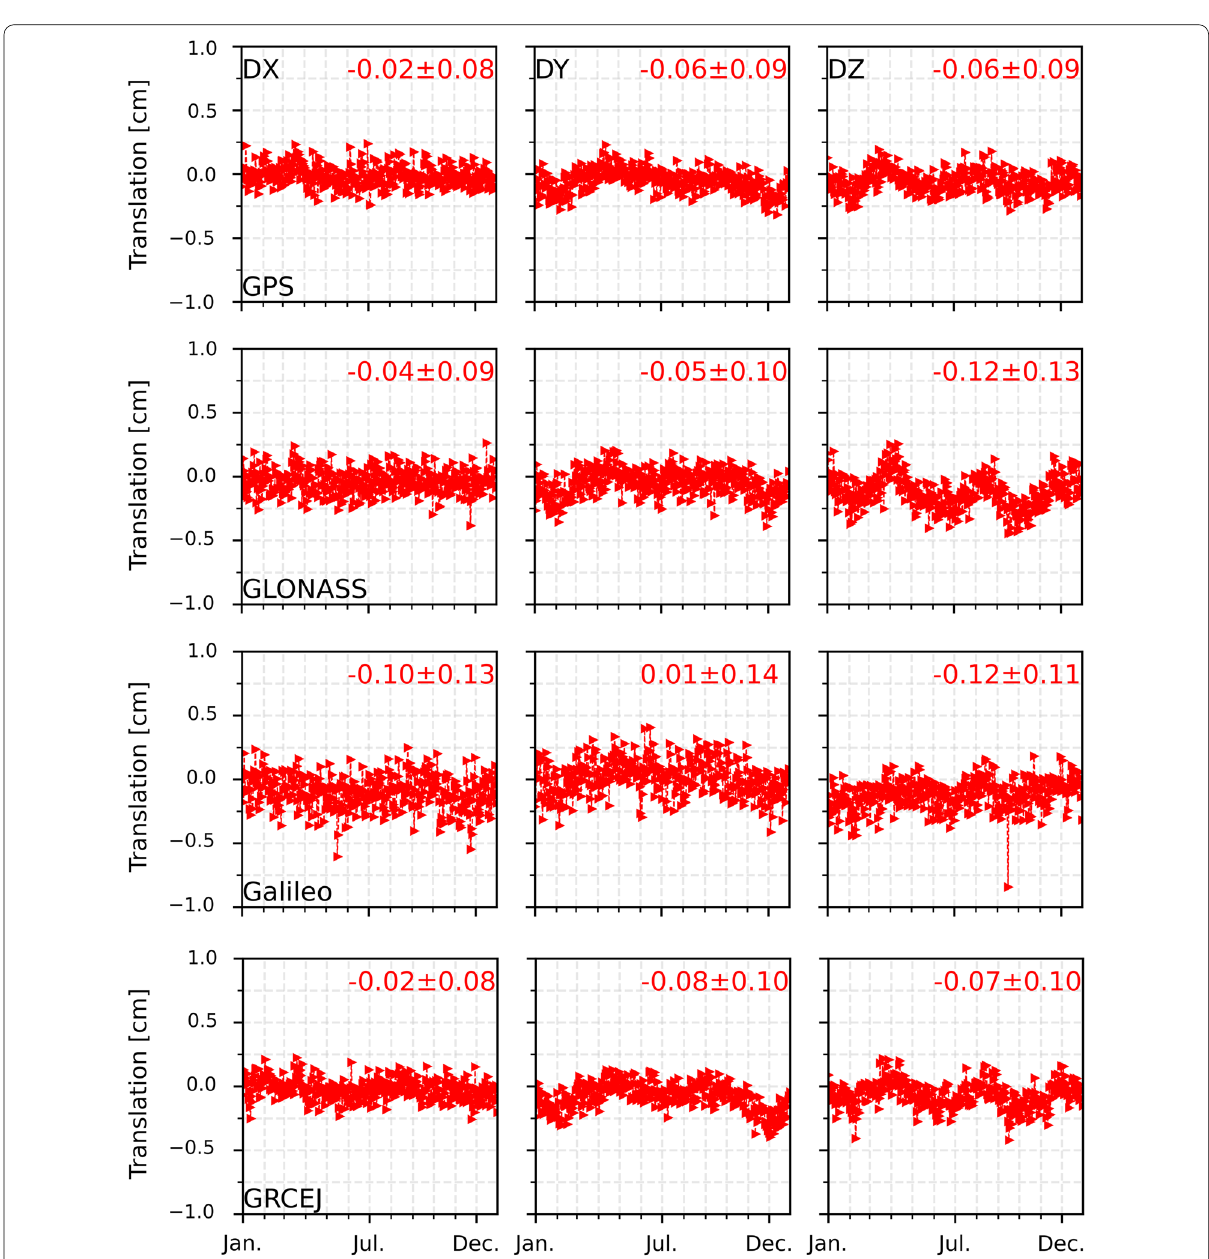
Fig. 9 Translations of the PPP solution determined with combined orbit and clock solutions with respect to the IGS daily solution. ‘GRCEJ’ indicates the translation of GPS, GLONASS, BDS-2, Galileo, and QZSS integrated PPP